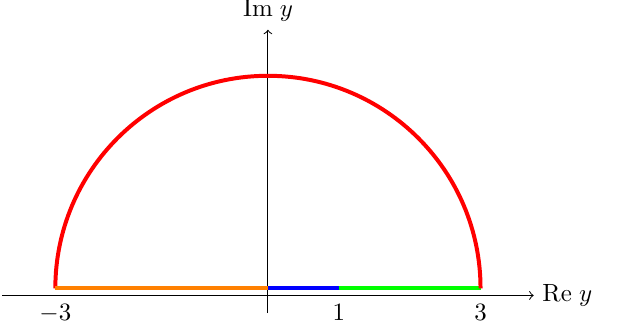
Figure 2 . The path in y -space. The interval y ∈ [ − 3 , 0] corresponds to x ∈ [16 , ∞ [ , the interval y ∈ [0 , 1] corresponds to x ∈ ] − ∞ , 0] , the interval y ∈ [1 , 3] corresponds to x ∈ [0 , 4] , the half-circle corresponds to x ∈ [4 , 16]